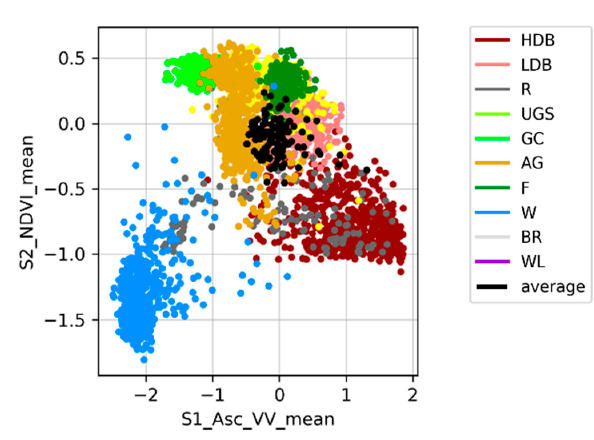
Figure 15. Scatterplots (S1, S2, S1&S2) of di ff erently combined high-ranking features